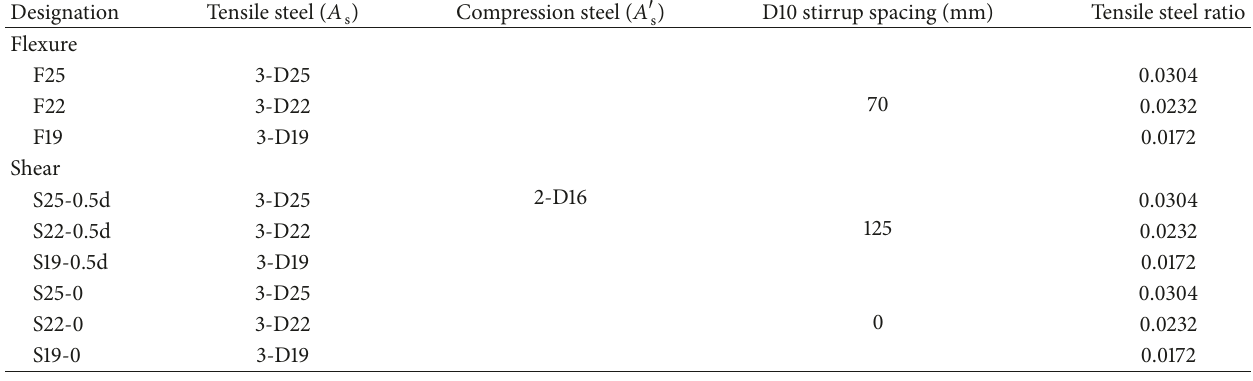
Table 3: Designation of beam specimen type and corresponding test variables.